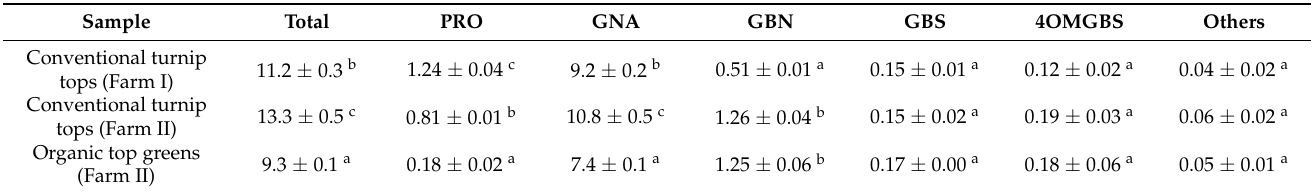
Table 9. Bioaccessible content ( µ mol/g dry weight) of total and individual glucosinolates in turnip tops (mean ± standard